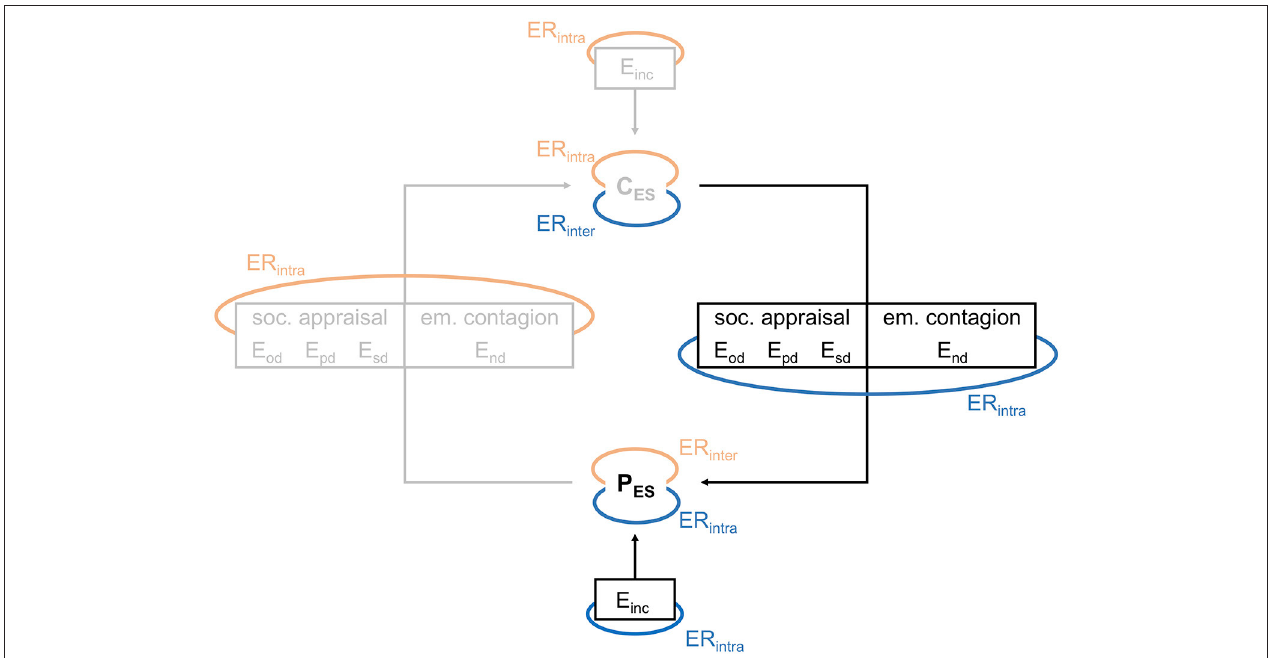
FIGURE 1 | Model for emotions and emotion regulation in provider-client interactions, part 1: Emotion transfer and emotion regulation. P ES /C ES , emotional state of the provider / client; E od , emotions elicited by object-directed interpersonal emotion transfer; E pd , emotions elicited by person-directed interpersonal emotion transfer; E sd , emotions elicited by self-directed interpersonal emotion transfer; E nd , emotions elicited by emotion contagion (non-directed); E inc , emotions elicited otherwise (incidental); ER intra , intrapersonal emotion regulation; ER inter , interpersonal emotion regulation. Blue: provider’s emotion regulation. Red: client’s emotion